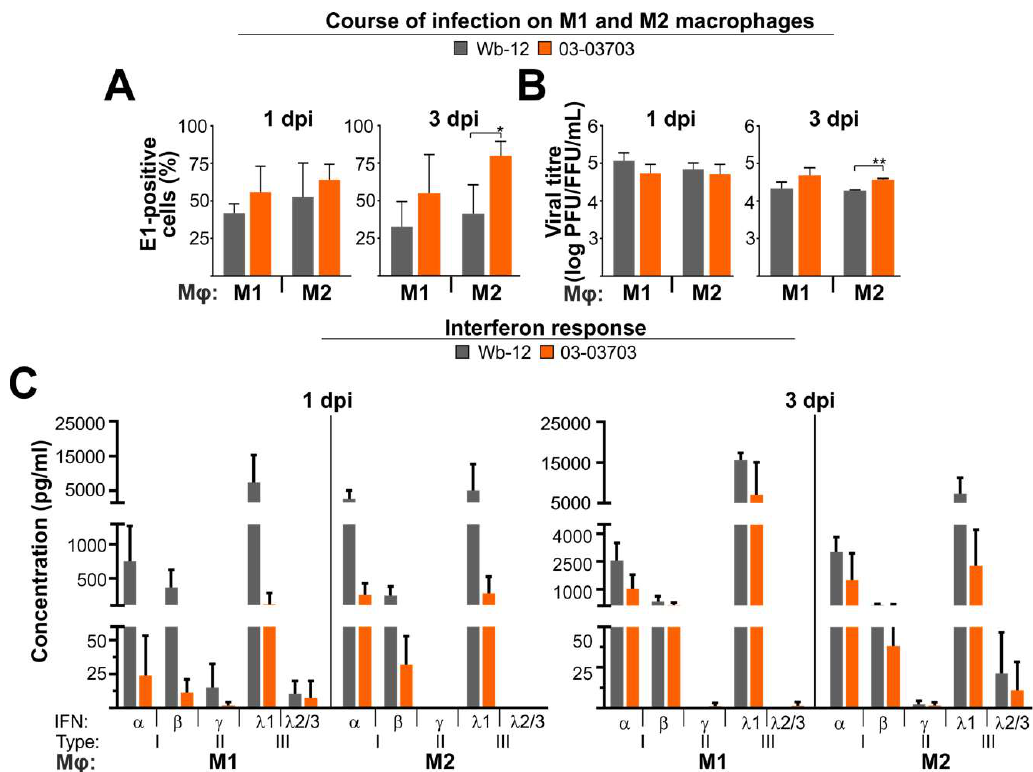
Figure 6. RV strains establish an equal infection rate on M1- and M2- macrophages (Mφ) and induce type I and III IFNs. ( A ) At 1 and 3 dpi RV-infected M1- and M2-Mφ were subjected to immunofluorescence analysis with an antibody against viral E1 protein. Percentage of E1-positive cells was determined for 5 independent microscopic fields obtained in three independent experiments. Supernatants collected at 1 and 3 dpi from M1- and M2-Mφ infected with indicated RV strains were collected and subjected to determination of ( B ) virus titre by plaque (PFU per mL) and